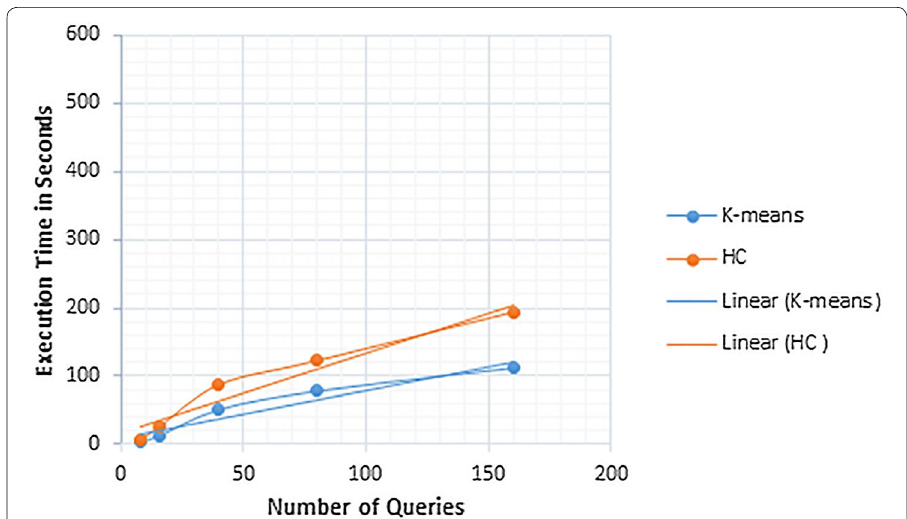
Fig. 4 Fragmentation execution time: visually exhibit time take to perform fragmentation by both methods hierarchical clustering and